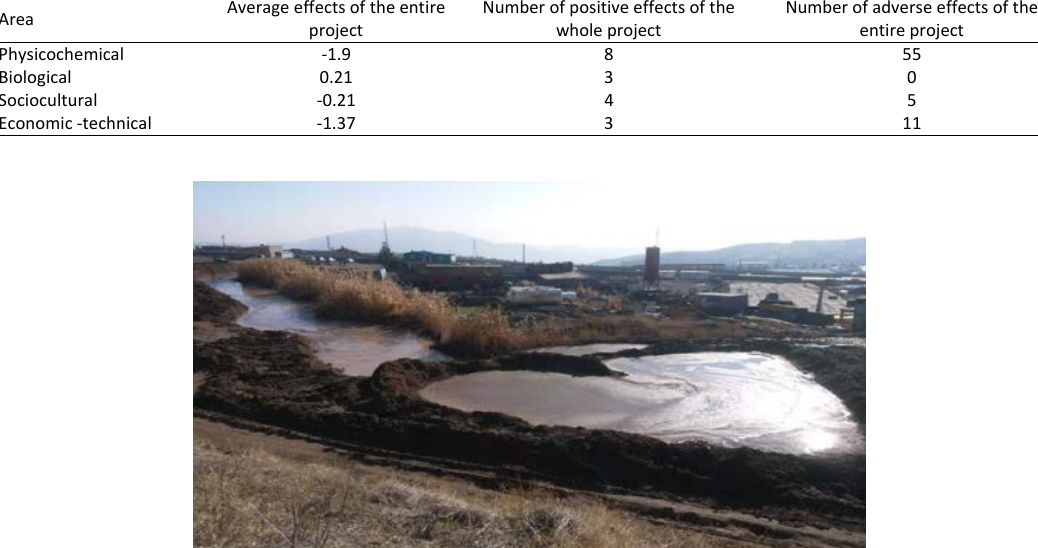
Table 6: Summary of the implementation of the factory construction plan, operation phase Area